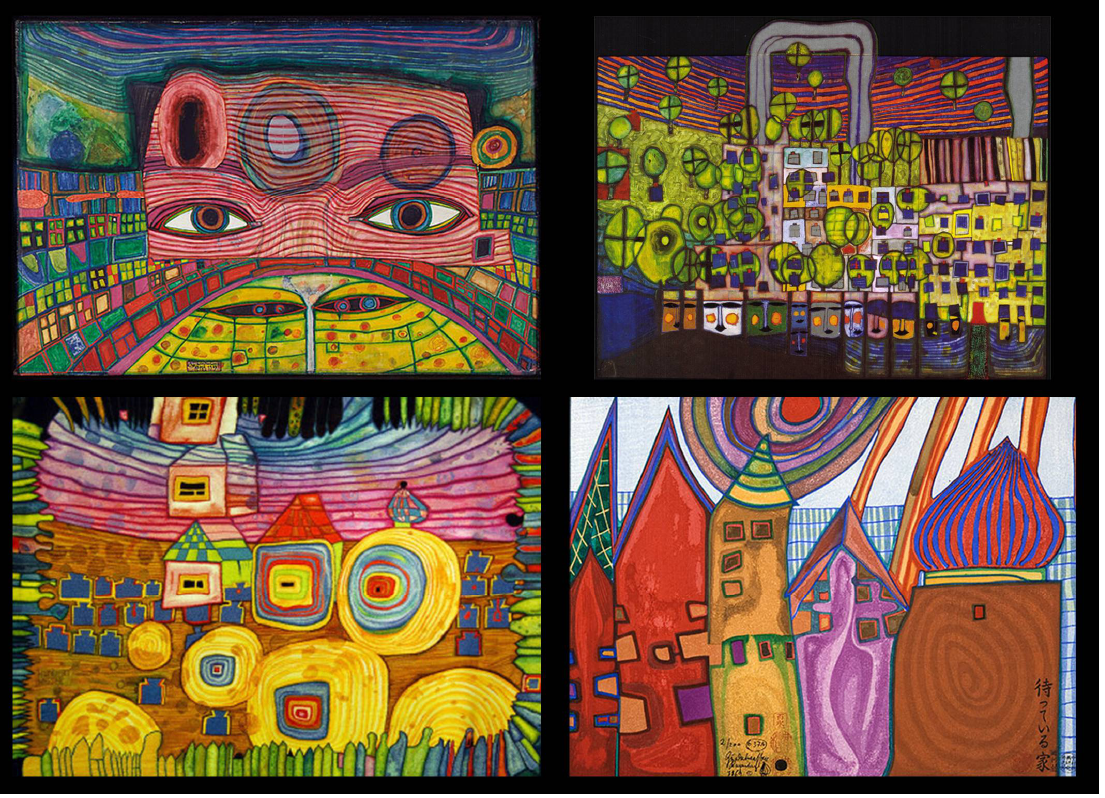
Figure 2. Hudertwasser’s